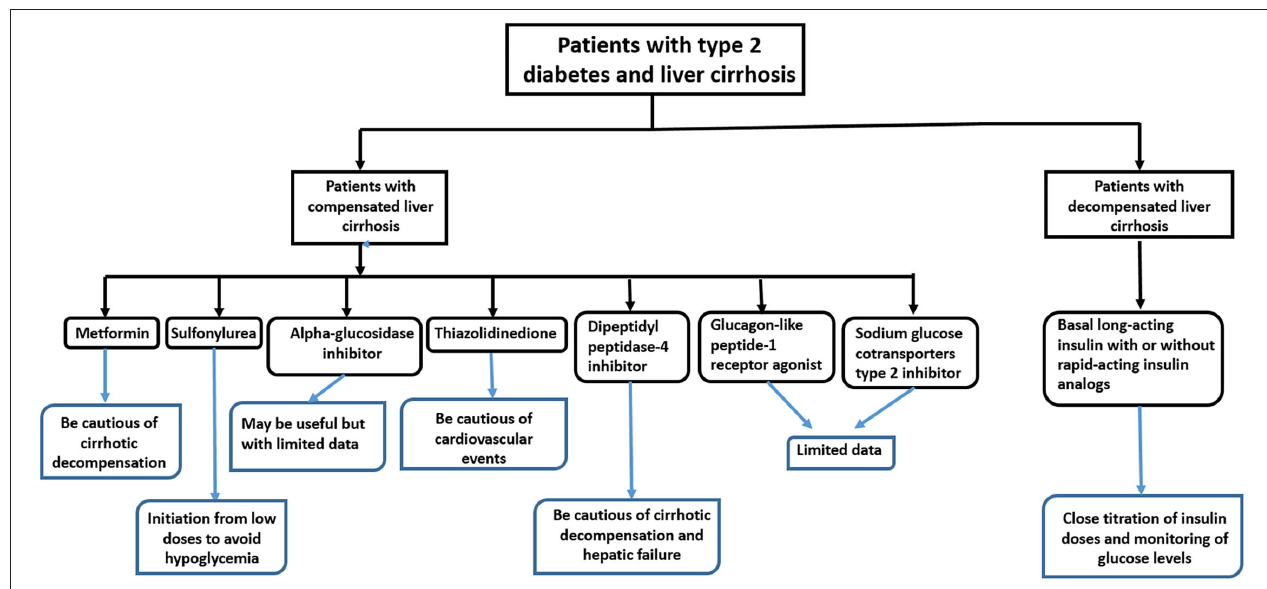
FIGURE 1 | The selection and warning of antidiabetic medications for patients with type 2 diabetes and liver cirrhosis.